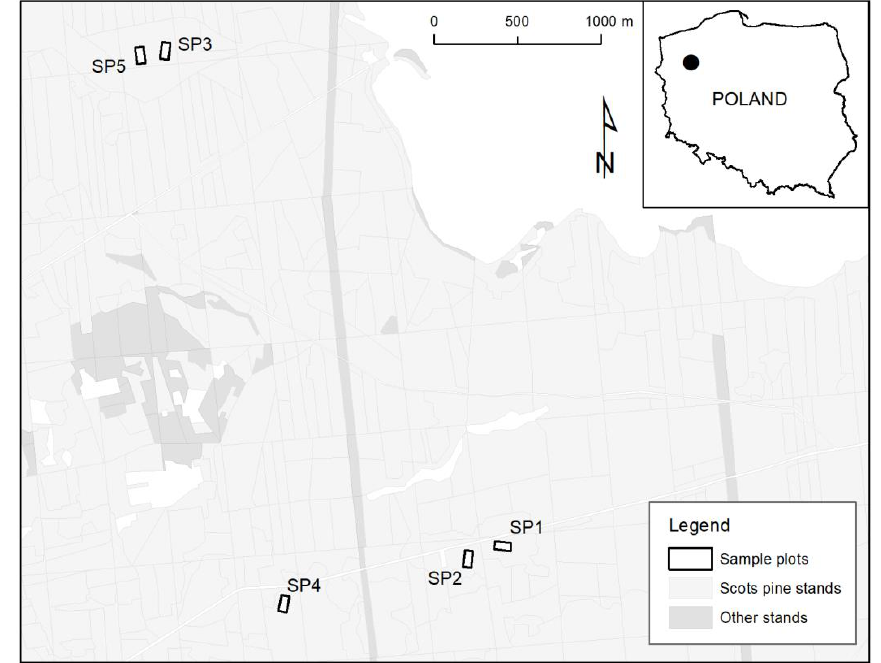
Figure 2. Distribution of sample plots (SP) in the southeastern part of the Drawno Forest District. Table 1. Main characteristics of five 82-year-old Scots pine sample stands.